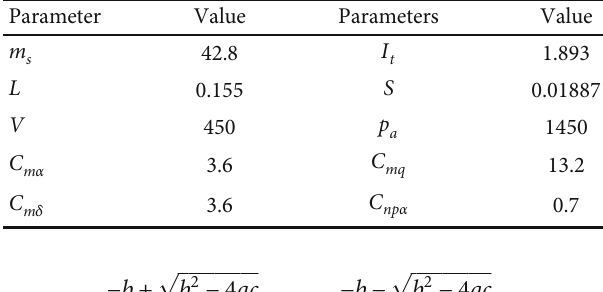
Table 1: Parameters of the 155 mm dual-spin